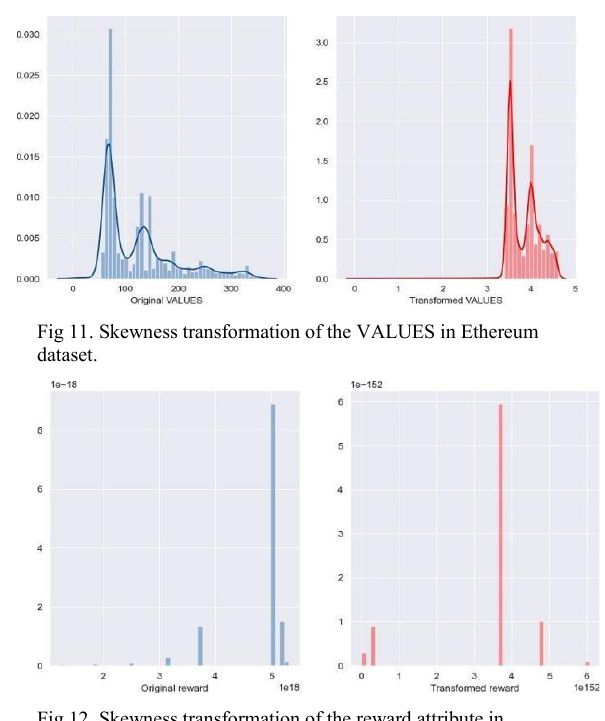
Fig 12. Skewness transformation of the reward attribute in Ethereum dataset.